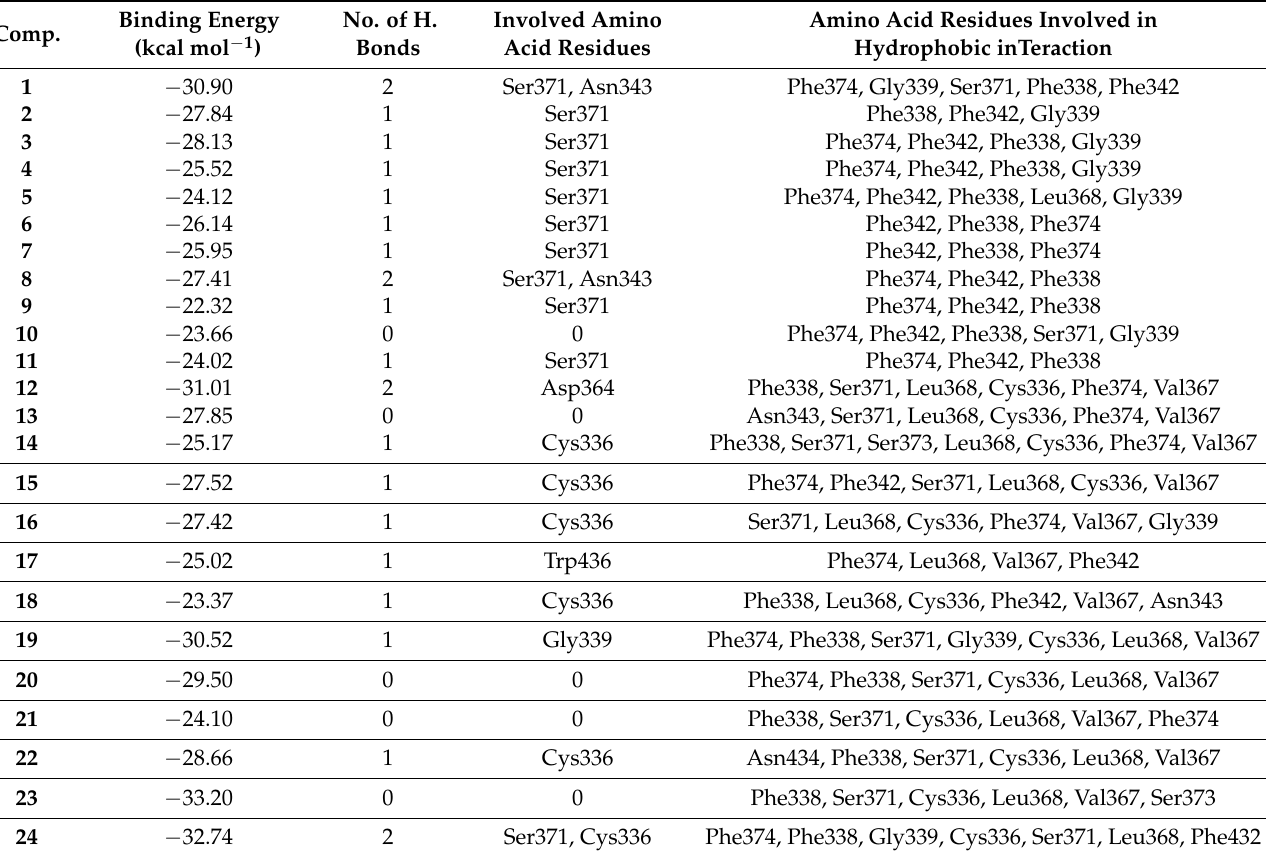
Table 3. Free binding energies of the selected isoflavonoids and the co-crystallized ligand (NAG) against hACE-2 and amino acid residues involved in H. bonds and hydrophobic interaction.